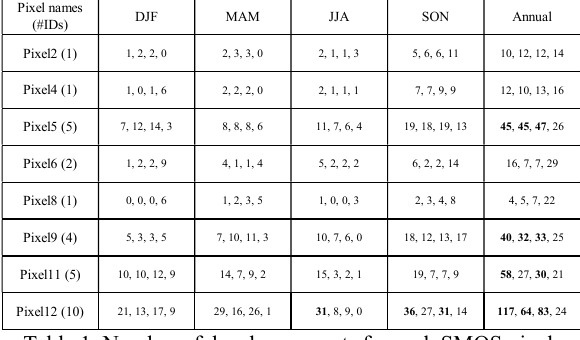
Table 1. Number of dry-down events for each SMOS pixel, season and the whole period (name as annual) in the following order: In-situ, In-situ_mSMOS, In-situ_mSMOS_004 and SMOS. Numbers between brackets are the amount of in-situ sites embedded in each SMOS pixel. In bold are values larger or equal than